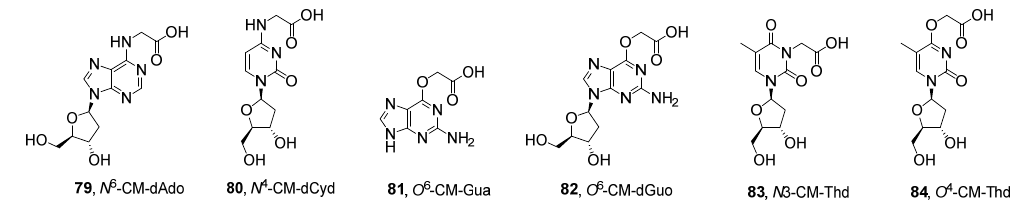
Figure 7. Structures of carboxymethyl DNA